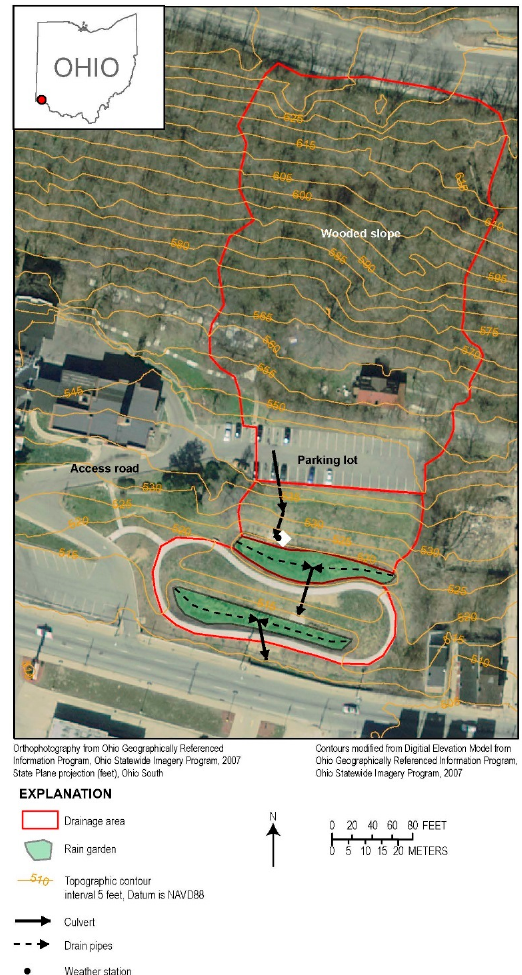
Figure 1. Site details for St. Francis rain garden network, drainage area, and conveyance infrastructure.